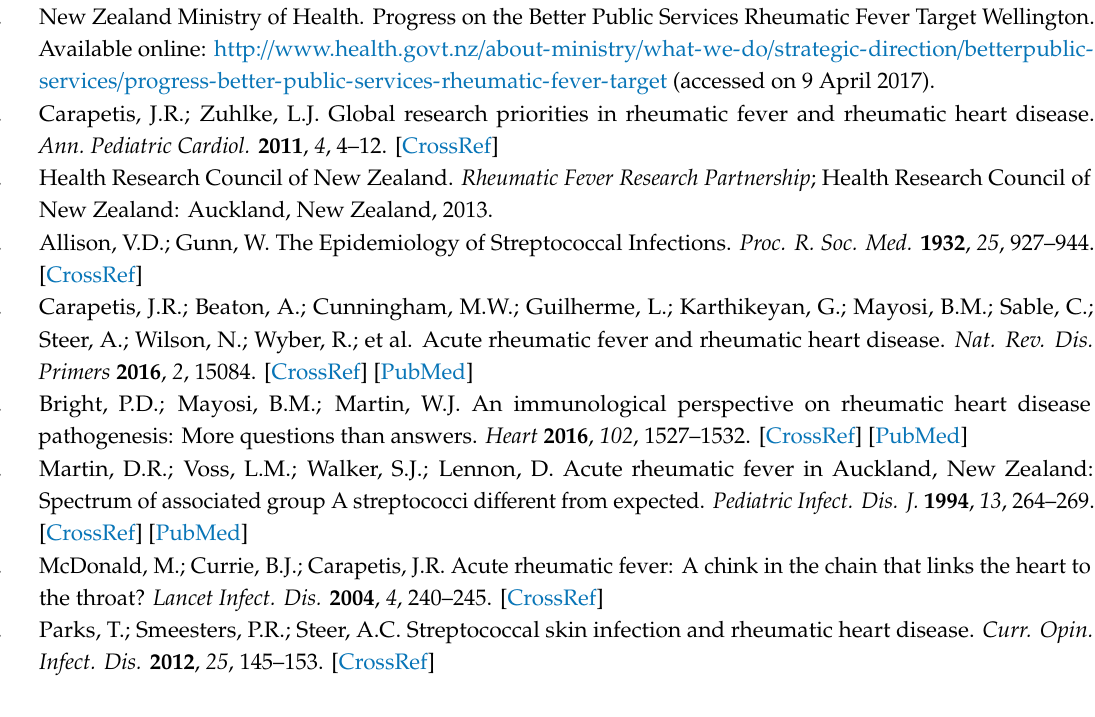
Table S1: Incidence of ARF hospitalisations by DHB, 2010–2014; Table S2: Summary of previous ARF and RHD risk factor studies; Table S3: Factors investigated in the ARF Risk Factors Study; Table S4: Potential risks to study e ff ectiveness and their management; Figure S1: Case recruitment algorithm used by